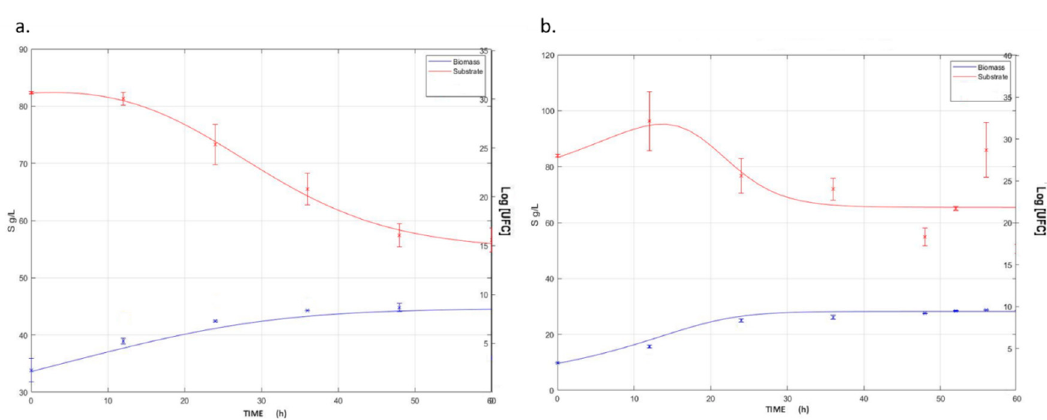
Figure 1. Time-profiles of L. plantarum ATCC 8014 biomass (blue line) and total carbohydrates (red line) concentrations obtained during batch submerged fermentation on media based on bovine blood plasma with hydrolyzed proteins. Discrete markers ( × ) correspond to the experimental data; the continuous lines were calculated by the kinetic model proposed. ( a ) Laboratory level (150 mL of working volume); ( b ) bench-scale level (2.5 L of working volume). Table 3. Kinetic parameters of the kinetic model of submerged fermentation at the bench scale for L. plantarum ATCC 8014 culture on a plasma-based medium. Source: Own